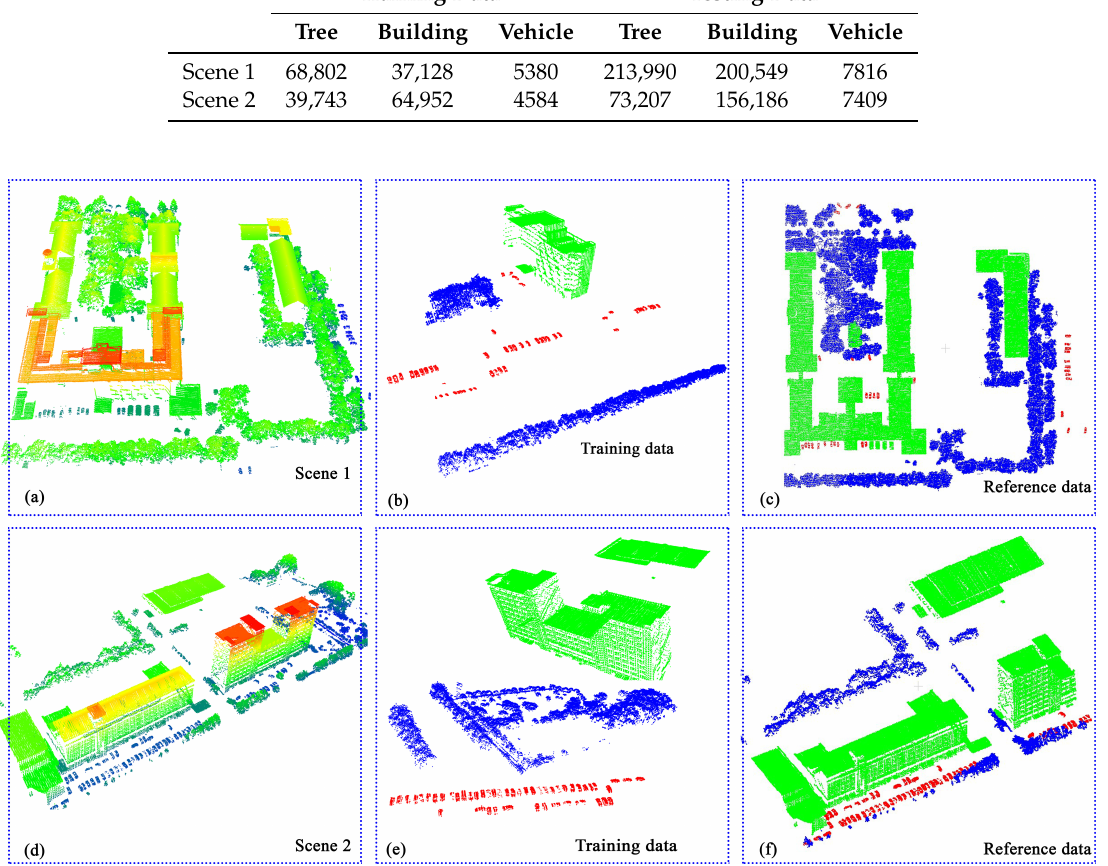
Figure 2. Two scenes for assessing the proposed algorithm. ( a , d ) are the residential and urban scenes in Tianjin. ( b , e ) are the selected points with semantic labels from ( a , d ) for training. The corresponding references are shown in subfigures ( c , f ). Please note that the point clouds in ( a , d ) are rendered according to point clouds’ elevation, and other colors represent the semantic information, i.e., blue = trees, green = buildings and red =